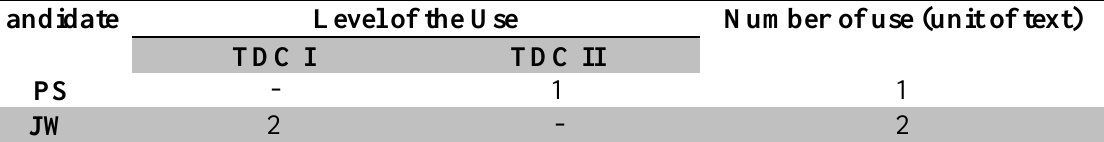
Table 4.1: The Level of the Use of Constant-Linear Pattern by Both Presidential